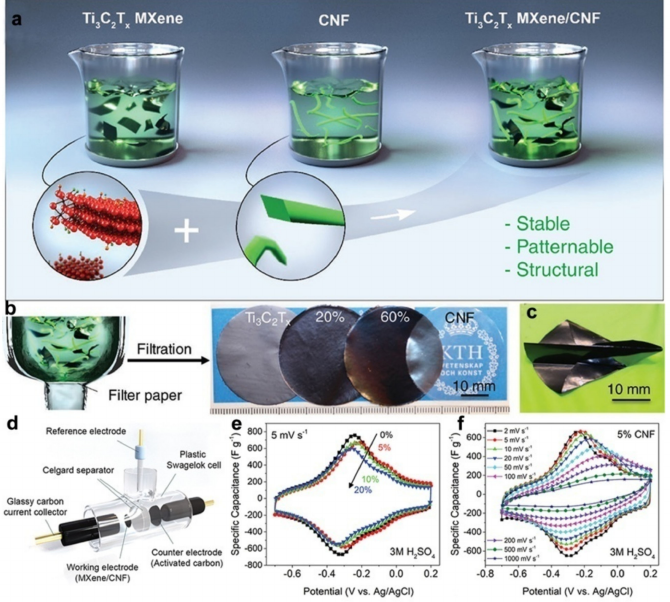
Figure 7. ( a ) Schematics of Ti 3 C 2 T x /CNF hybrid dispersion. ( b ) The synthesis method and digital photographs of Ti 3 C 2 T x /CNF nanopapers. ( c ) Photos of a Ti 3 C 2 T x /CNF nanopaper. ( d ) Schematic of the three-electrode system in this work. ( e ) CV curves of MXene with different ratio of CNF. ( f ) CV curve of Ti 3 C 2 T x –5% CNF electrode at various scan rates